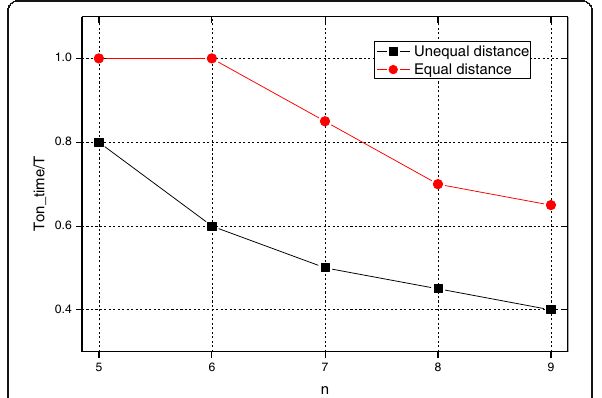
Fig. 30 The maximum energy consumption reduction ratio of UDNP